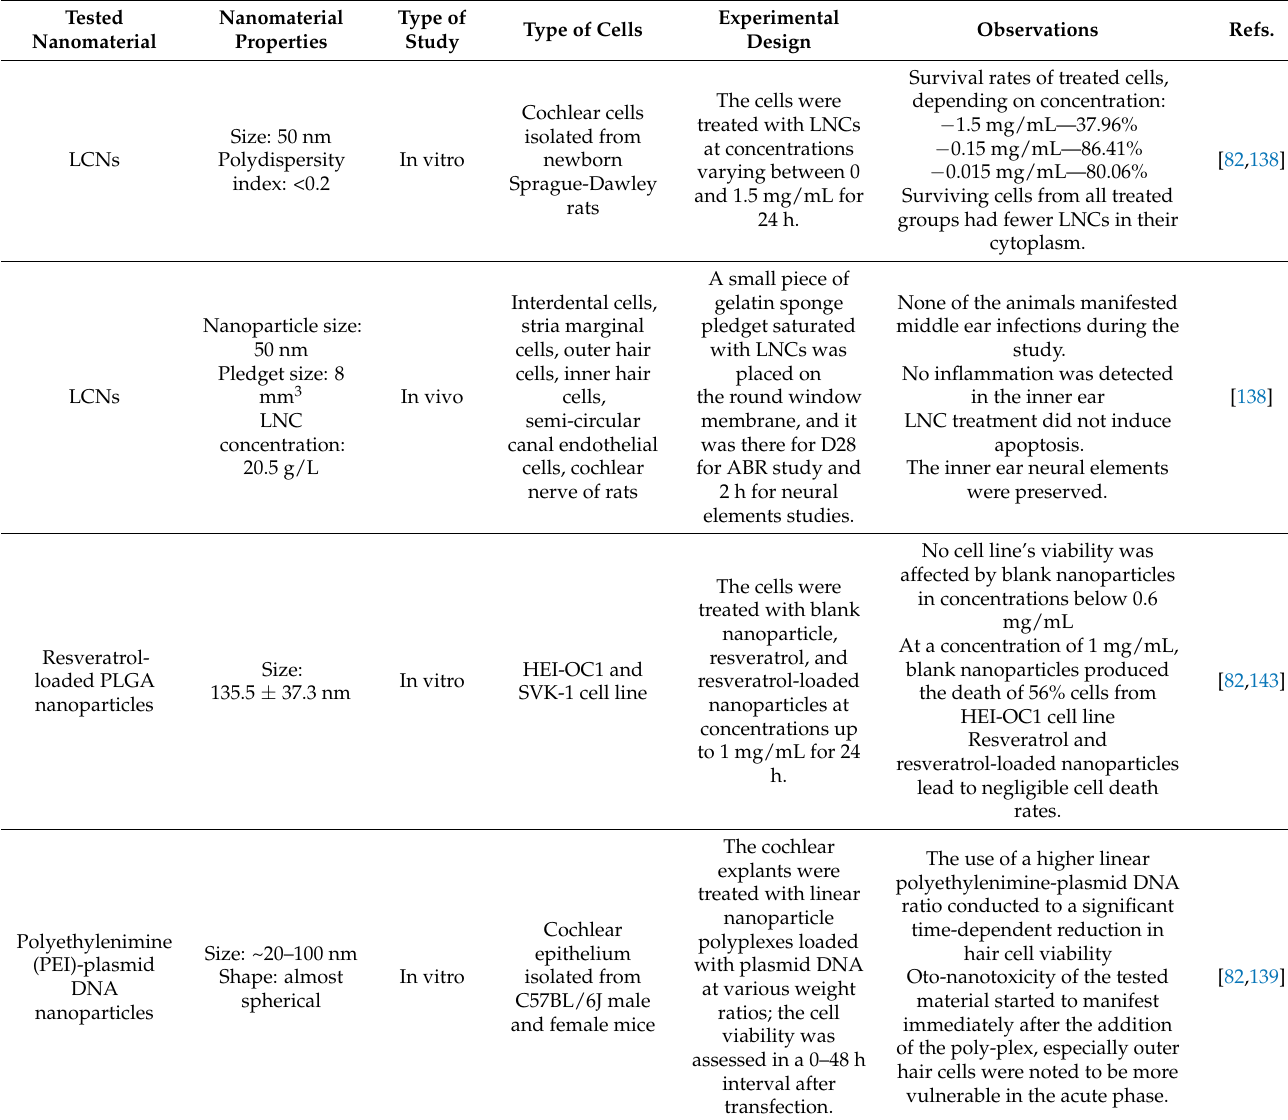
Table 1. Summary of studies on nanomaterials potential side effects on inner ear